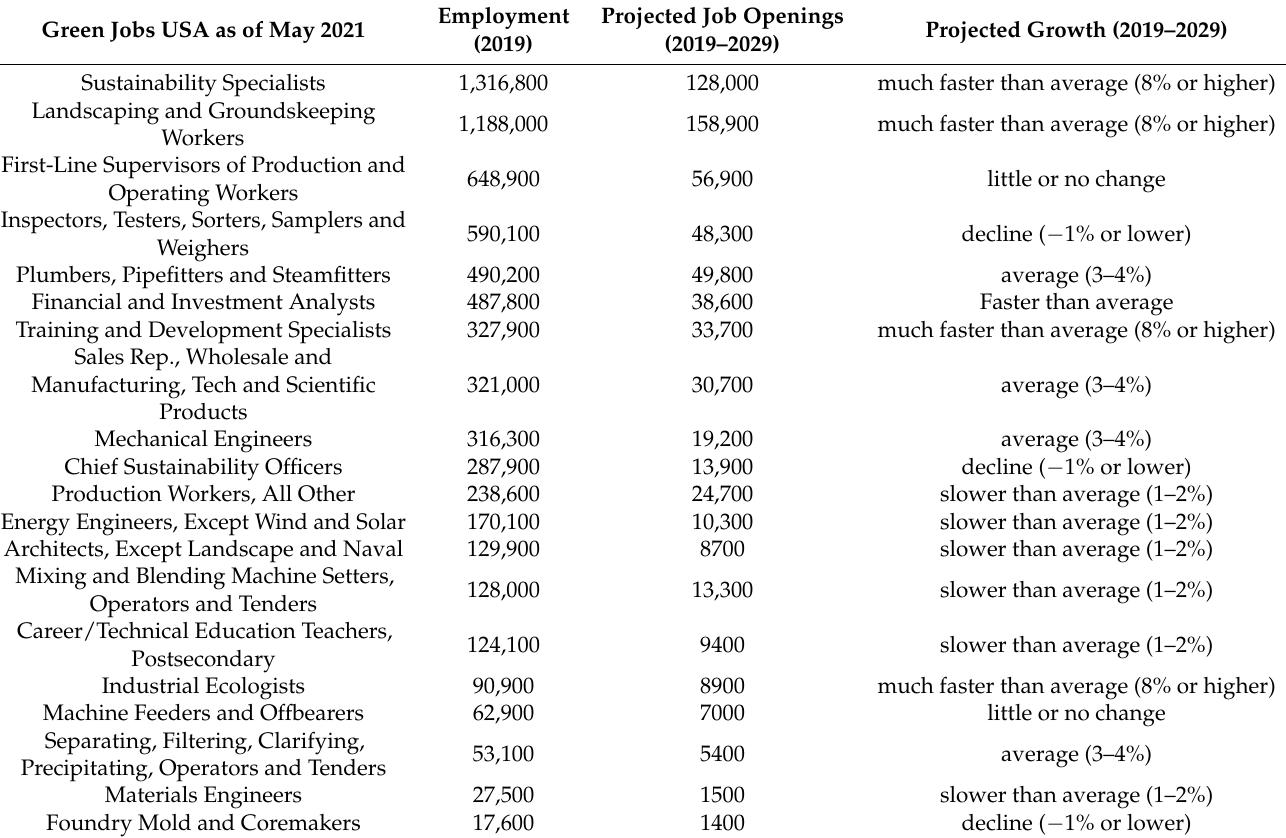
Table 1. Green jobs in USA, 2021. Source: own elaboration based on data from O*NET [34]. Green Jobs USA as of May